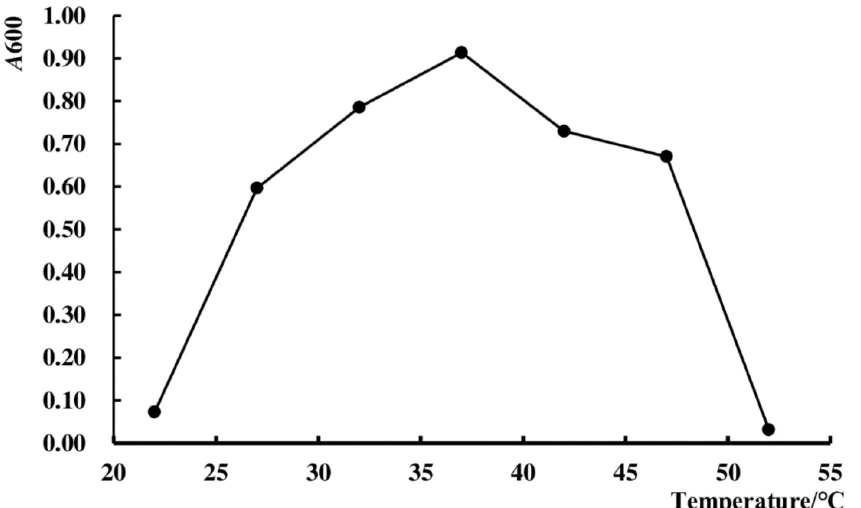
Fig 7. Effects of temperature on the growth of strain